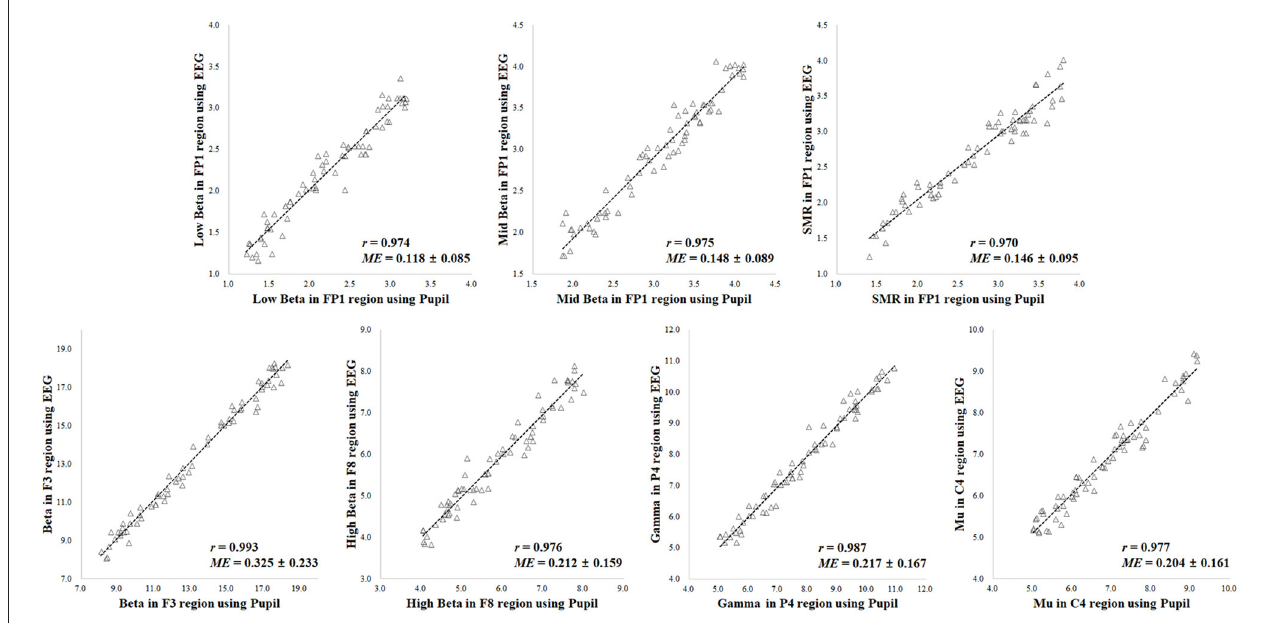
FIGURE 5 | Results of correlation analysis in reference state for coefficient ( r ) and mean error ( ME ) of electroencephalogram (EEG) spectral index between the pupil and EEG signals ( p < 0.001 [ n = 70]).